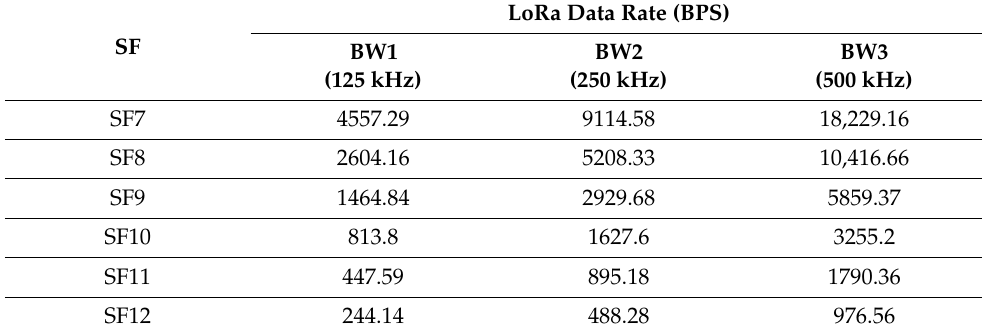
Table 6. LoRa data rate/bit rate at CR2.